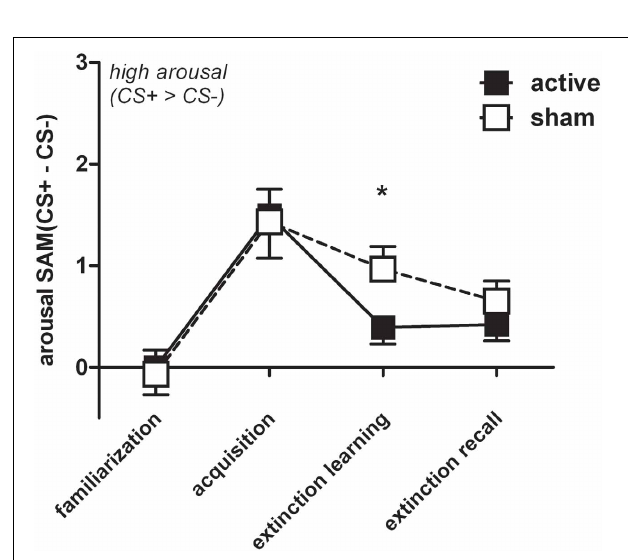
FIGURE 6 | For reasons of visualization arousal difference scores ( CS + minus CS − ) were depicted (M + SEM) during familiarization, acquisition, extinction learning, and extinction recall for the active ( n = 32) and the sham group ( n = 30). Groups significantly differed during extinction learning ( ∗ p < 0 . 05), i.e., sham showed higher arousal for CS + than CS −